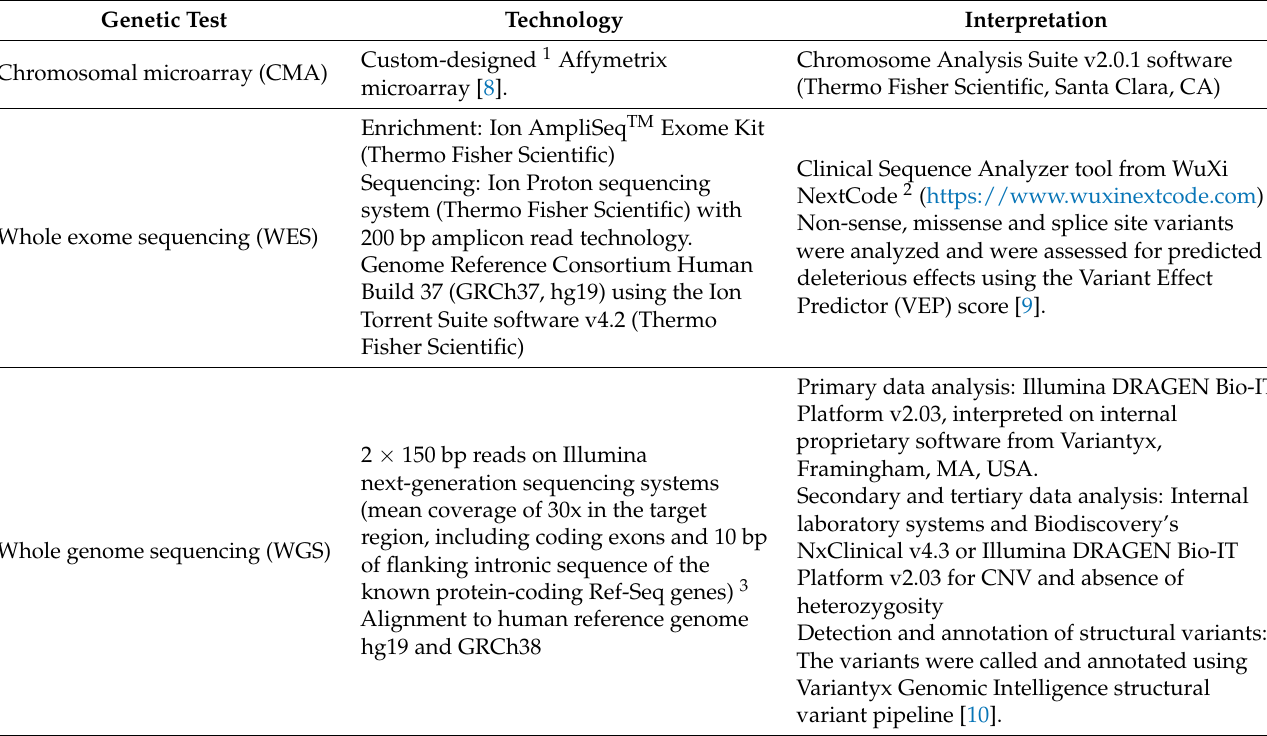
Table 1. Genetic testing methodologies utilized for Prof. Grandin in this study. Genetic Test Technology Interpretation Chromosomal microarray